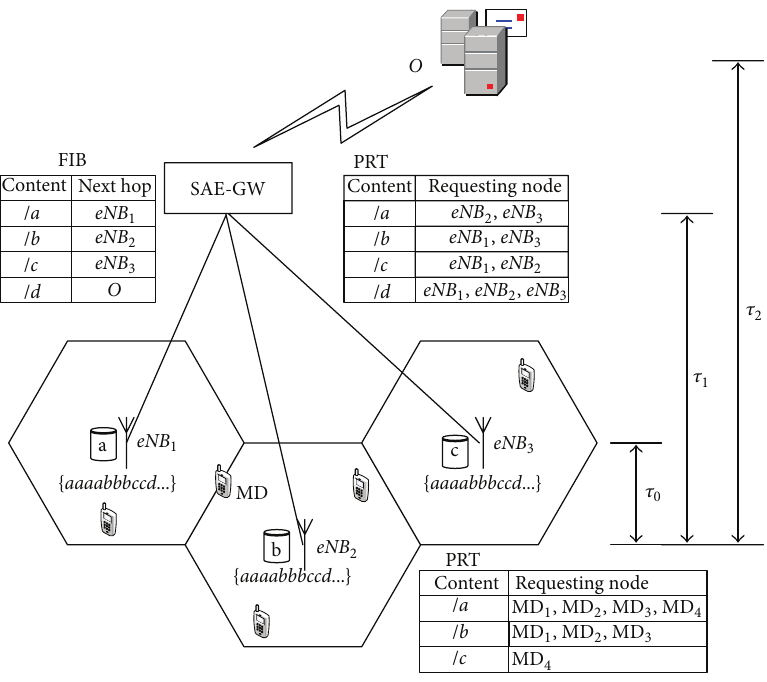
Figure 3: A motivating